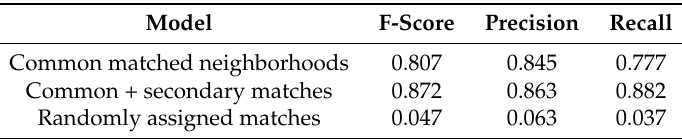
Table 4. F-score, precision and recall values for two random forest models trained and tested on listings from Washington, DC. Accuracy values for a model built on random assignments are also shown for comparison.